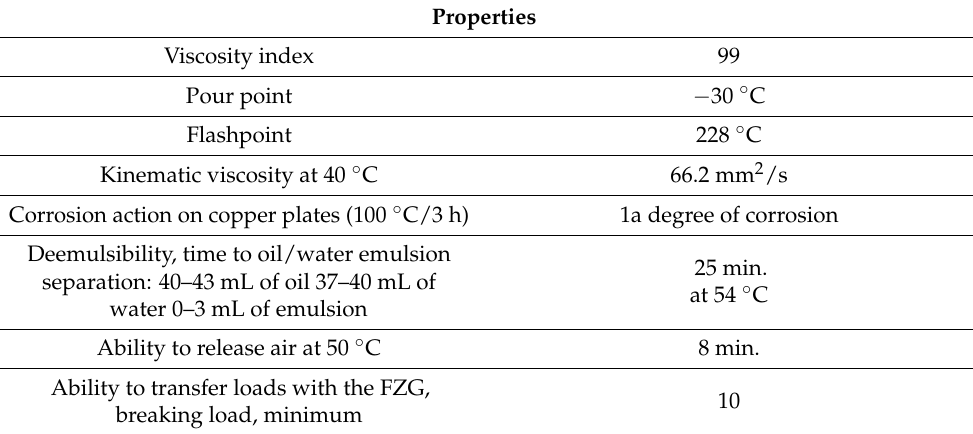
Table 3. The basic properties of hydraulic oil HLP 68.